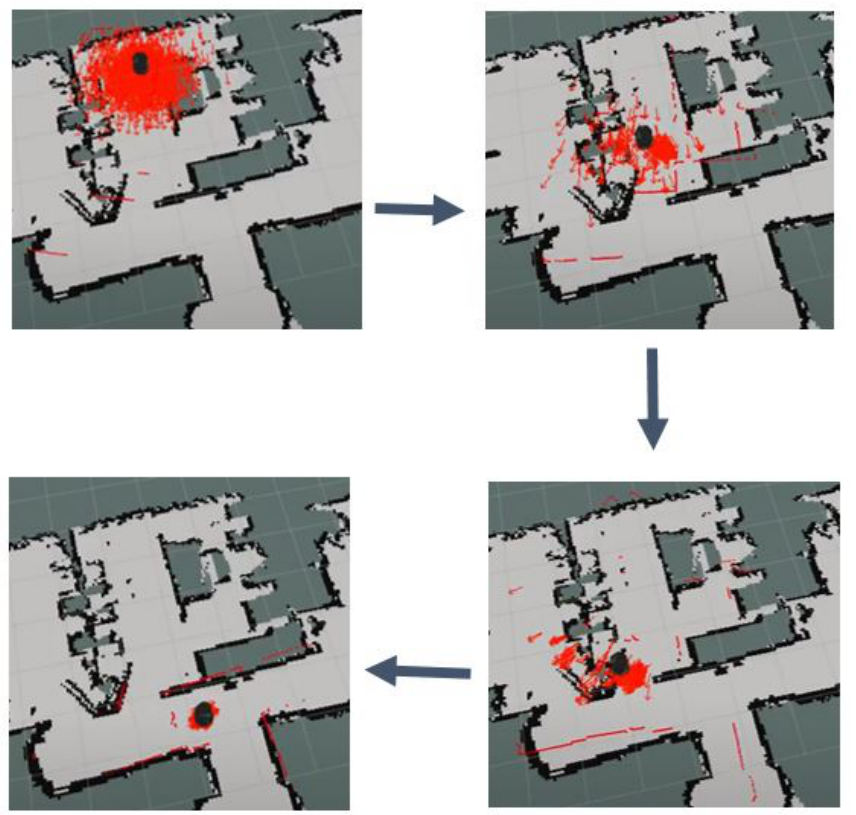
Figure 6. Particle filters are initially spread out but become more concentrated as more data is gathered from the laser scans while constantly being compared to the map, leading to better pose